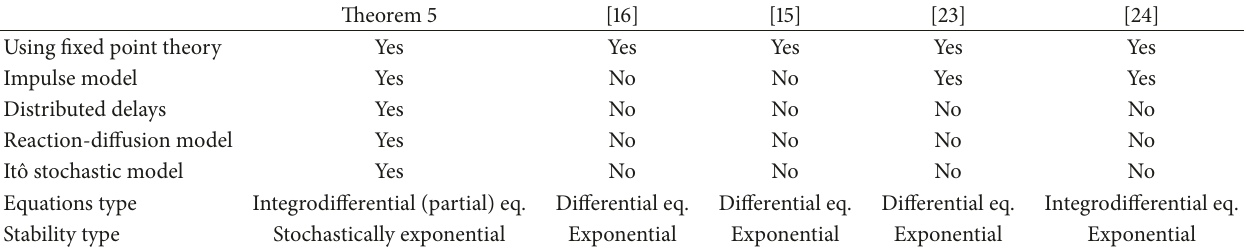
Table 1: Comparison of the complexity of system models in the literature related to fixed point